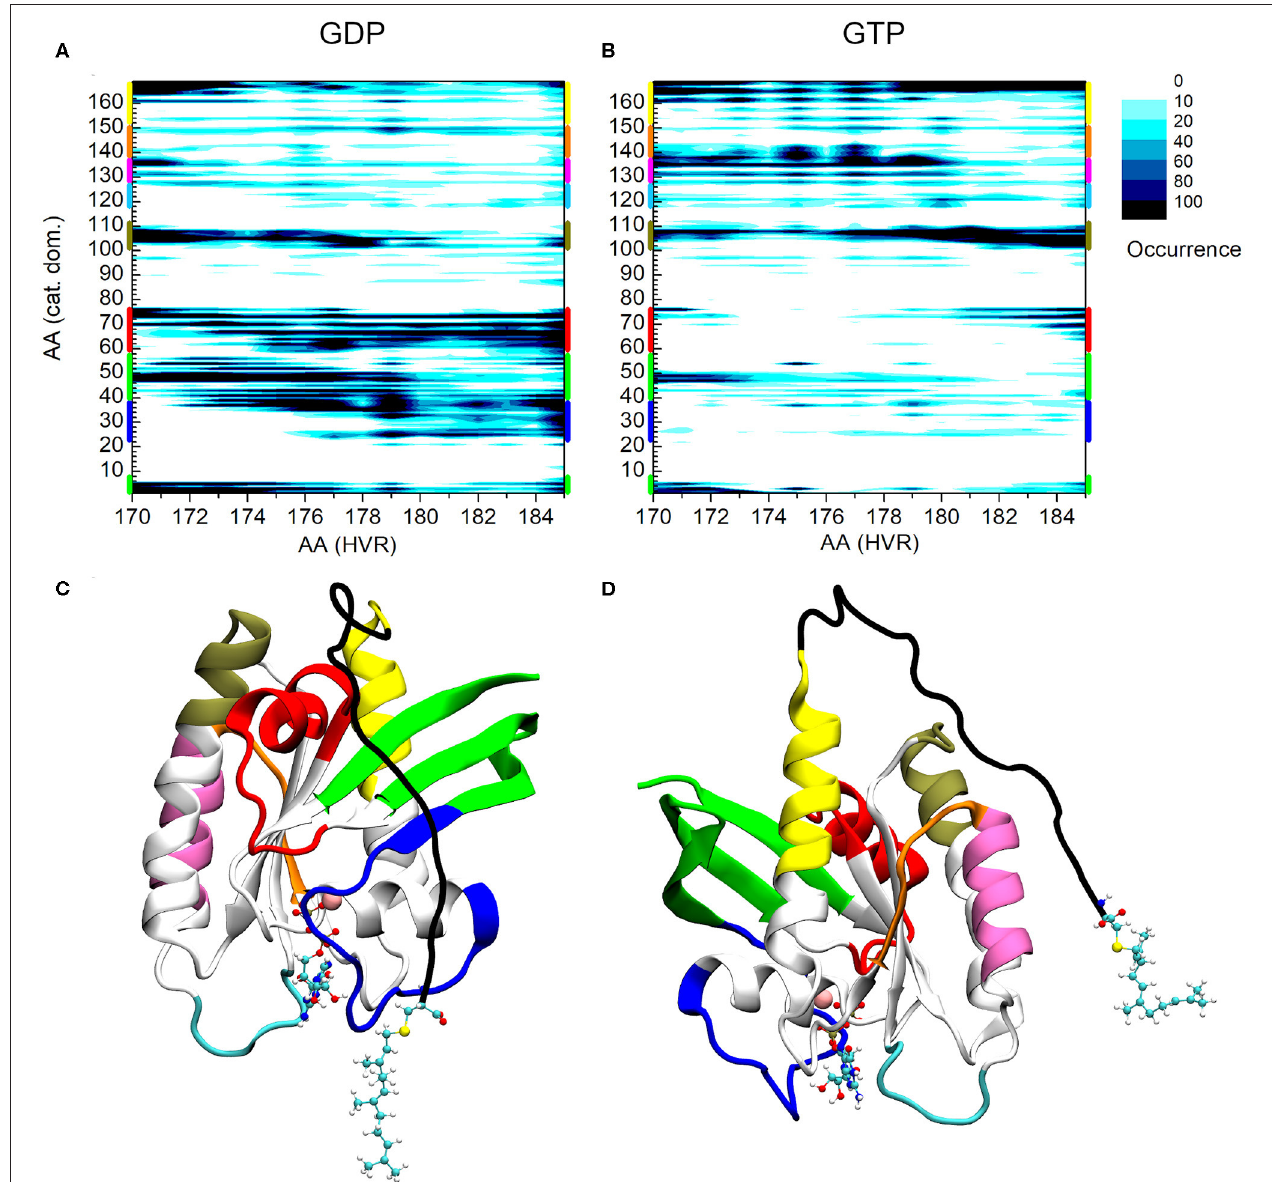
FIGURE 2 | Distance-based interaction map between the catalytic domain and the HVR of K-Ras4B. (A) GDP-bound, (B) GTP-bound state. (C) 3D structure of K-Ras4B with the effector lobe and (D): the allosteric lobe in front. The nucleotide and the farnesyl group are represented as CPK, Mg 2 + as VDW sphere. Structural regions of the catalytic domain color-coded along the y-axis of (A) and (B) are mapped with identical coloring onto the C and D part of the figure.